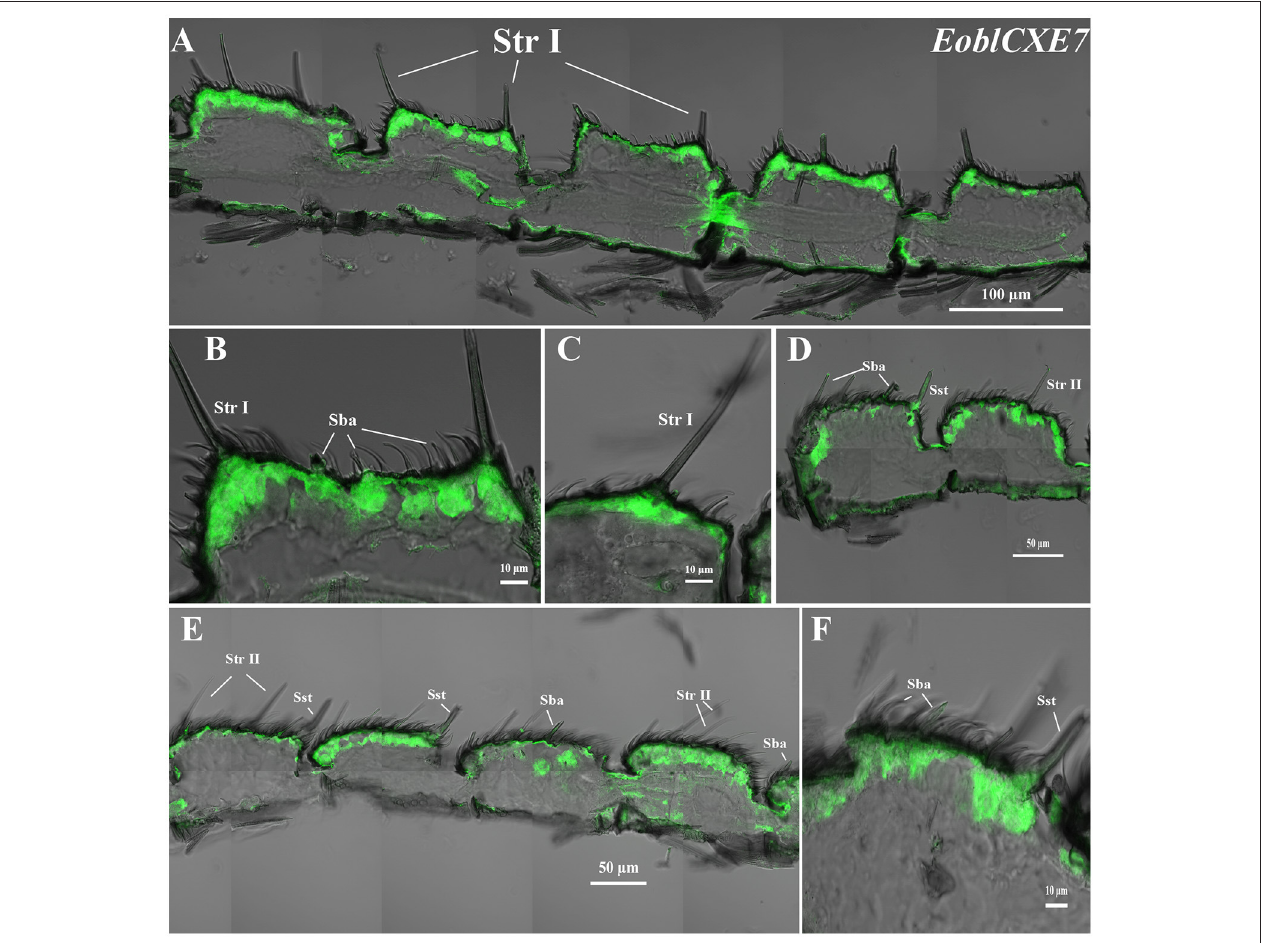
FIGURE 4 | Localization of the EoblCXE7 gene in different antennal sensilla of both sexes, as revealed via fluorescence in situ hybridization. (A–C) male antennae; (D–F) female antennae; Str I, sensilla trichodea I; Str II, sensilla trichodea II; Sba, sensilla basiconica; Sst, sensilla